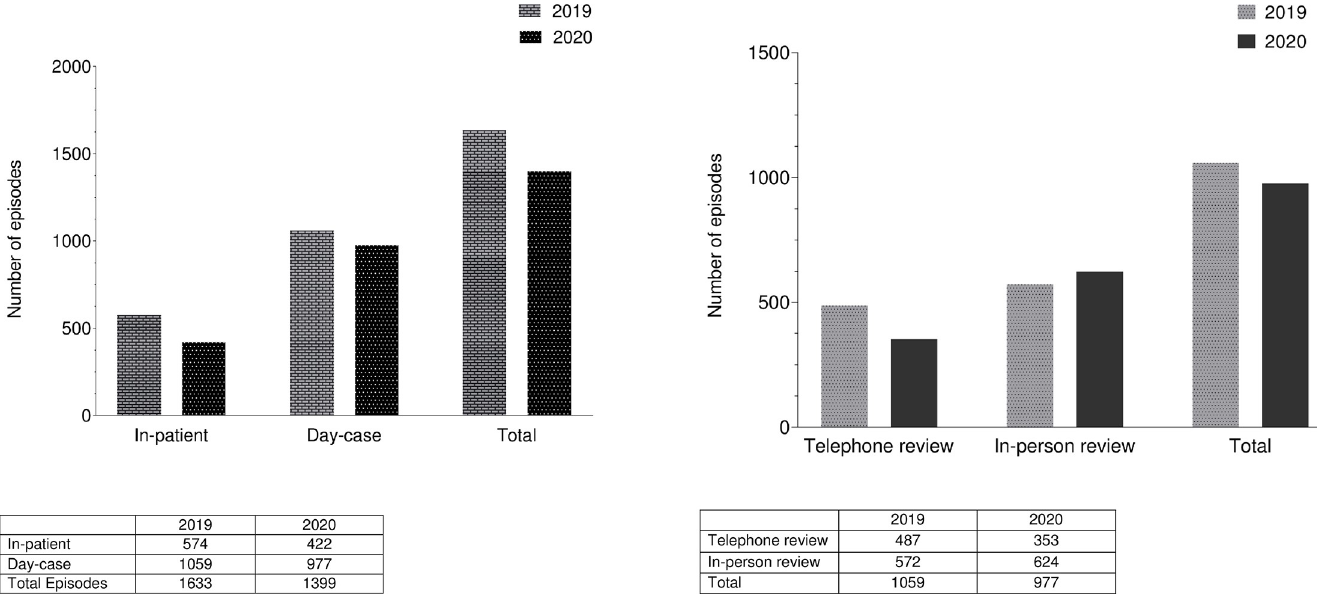
Fig 3. A). Patient episodes reviewed on in-patient and day-case basis in 2020 compared to in-patient and day-case basis in 2019. B) Day-case episodes reviewed in- person and on the telephone in 2020 compared to in-person and telephone review in